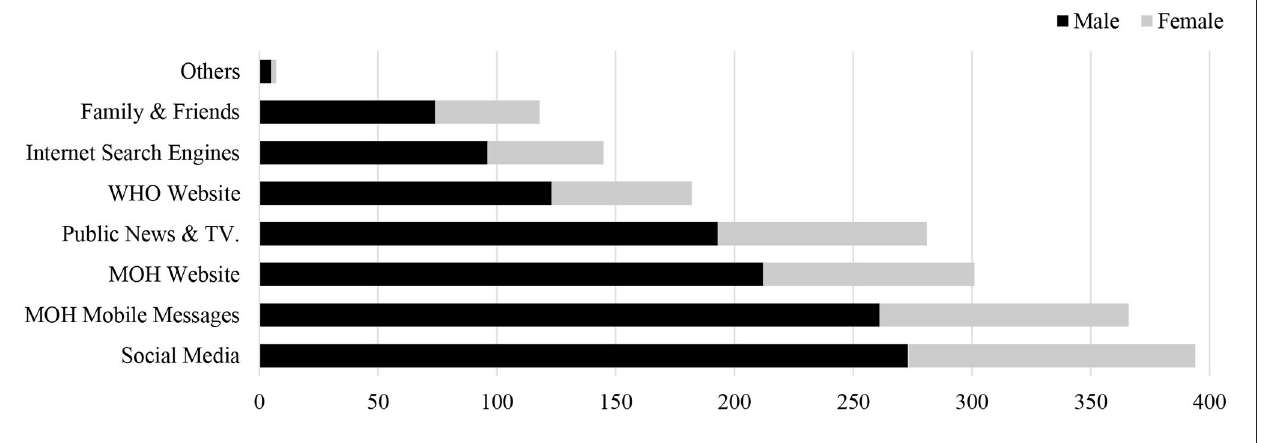
FIGURE 1 | COVID-19 information sources by